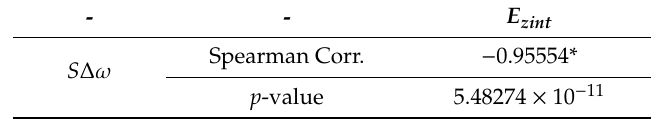
increase, rad · s − 1 . Table A7. Results of the correlation analysis with the Spearman method for the process of rice grinding. - - E zint Spearman Corr. − 0.95554* S ∆ ω p -value 5.48274 × 10 − 11